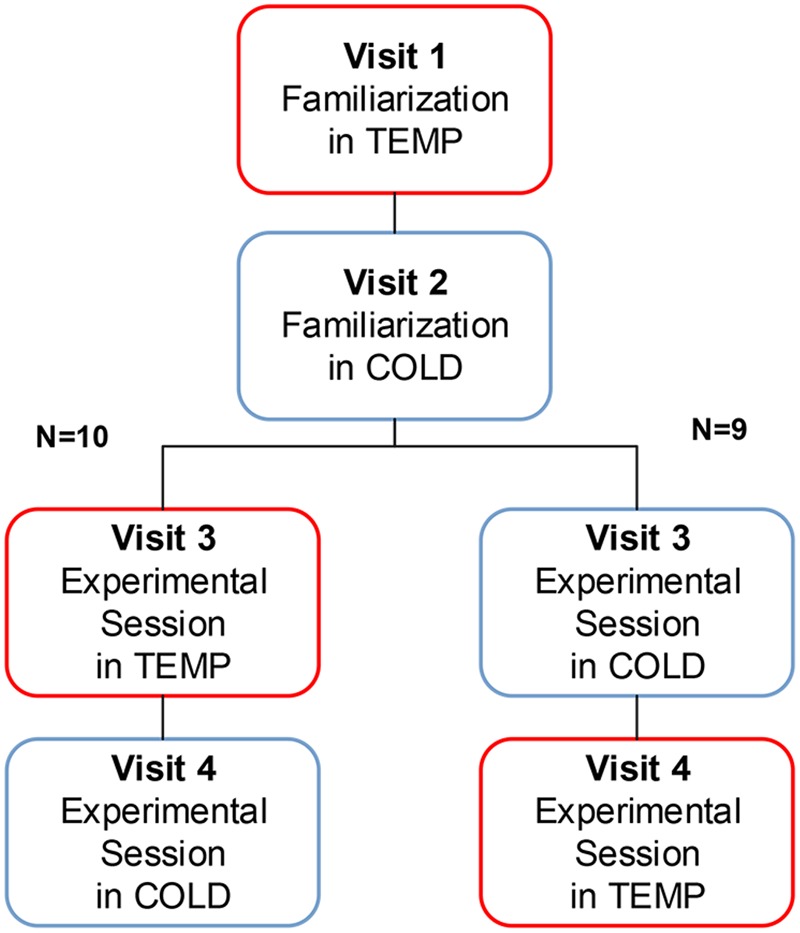
Overview study design.